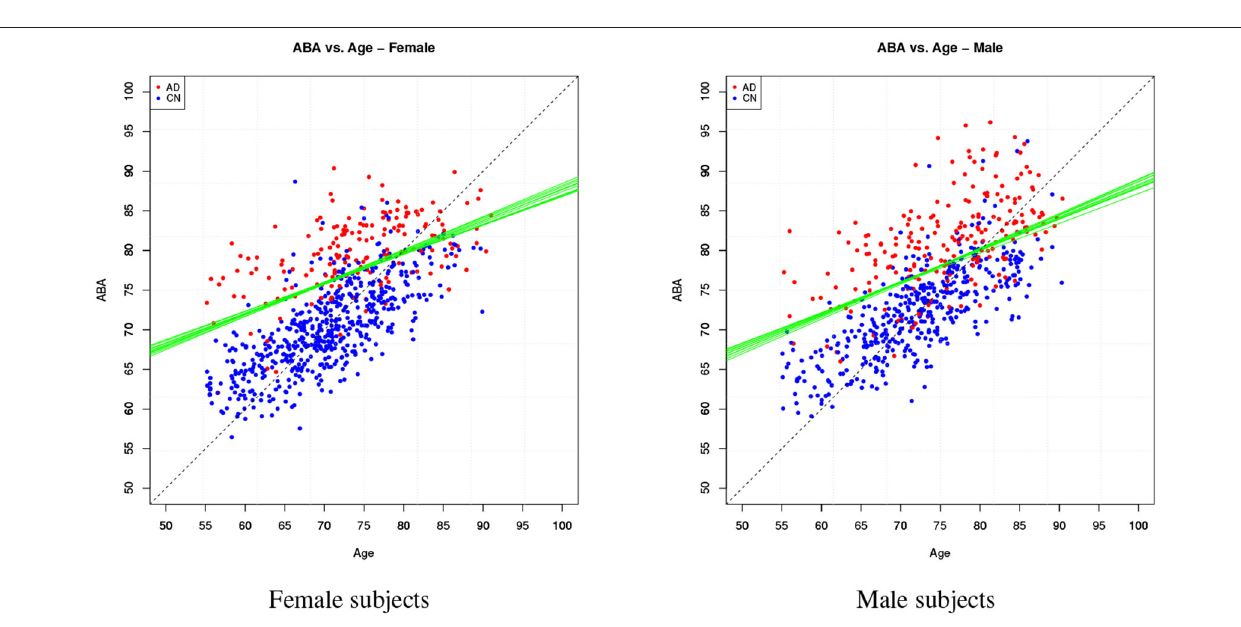
FIGURE 6 | Method M5: ABA vs. Age plots for both gender